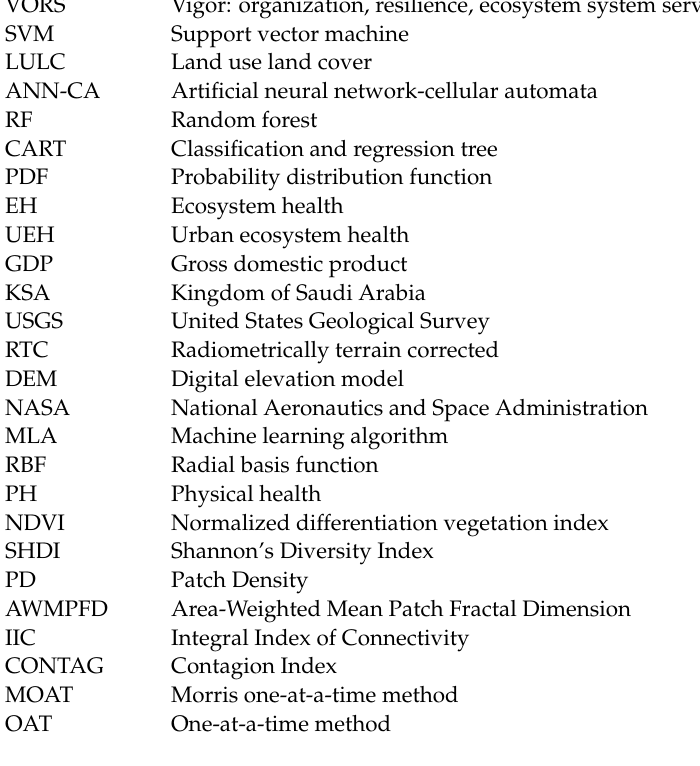
Table S6: Transitional probability matrix between the LULC maps of 1990 and